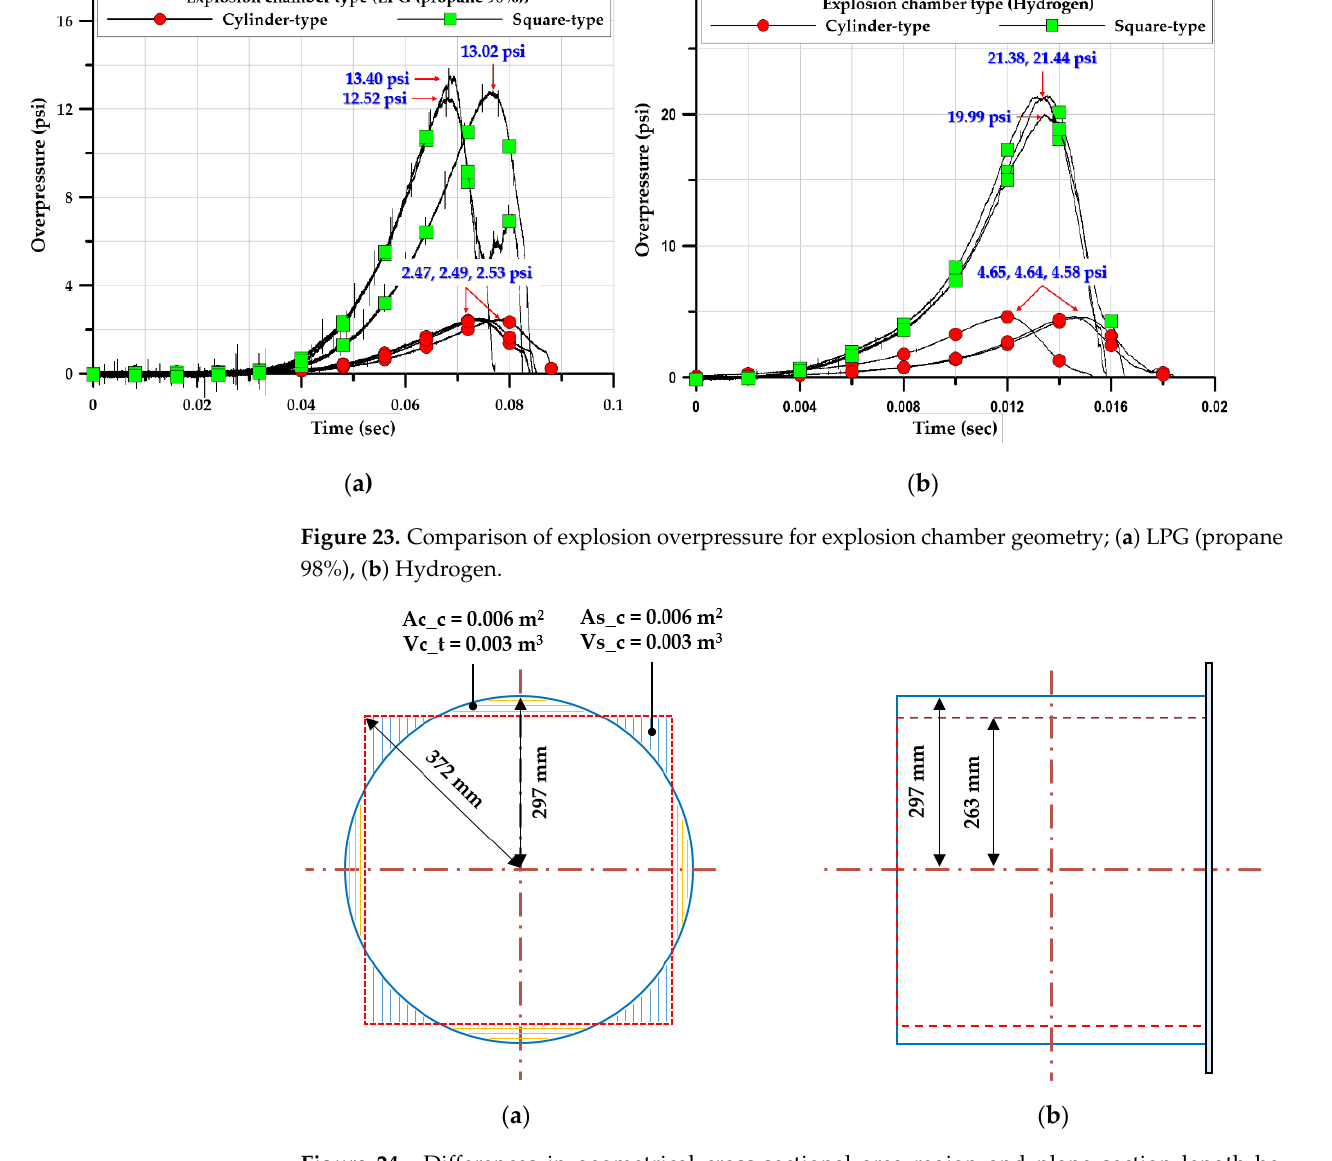
Figure 24. Differences in geometrical cross-sectional area region and plane section length between the cylindrical and square chambers; ( a ) Cross-section area comparison, ( b ) Plane-section length comparison.